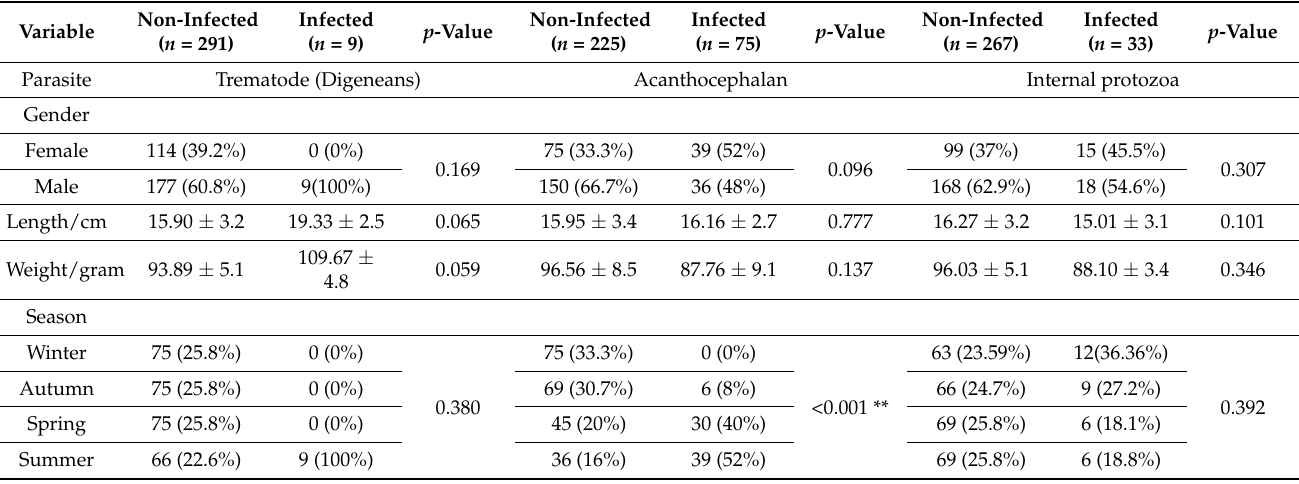
Table 4. Prevalence of endoparasites in relation to sex, size and seasonal condition in Nile